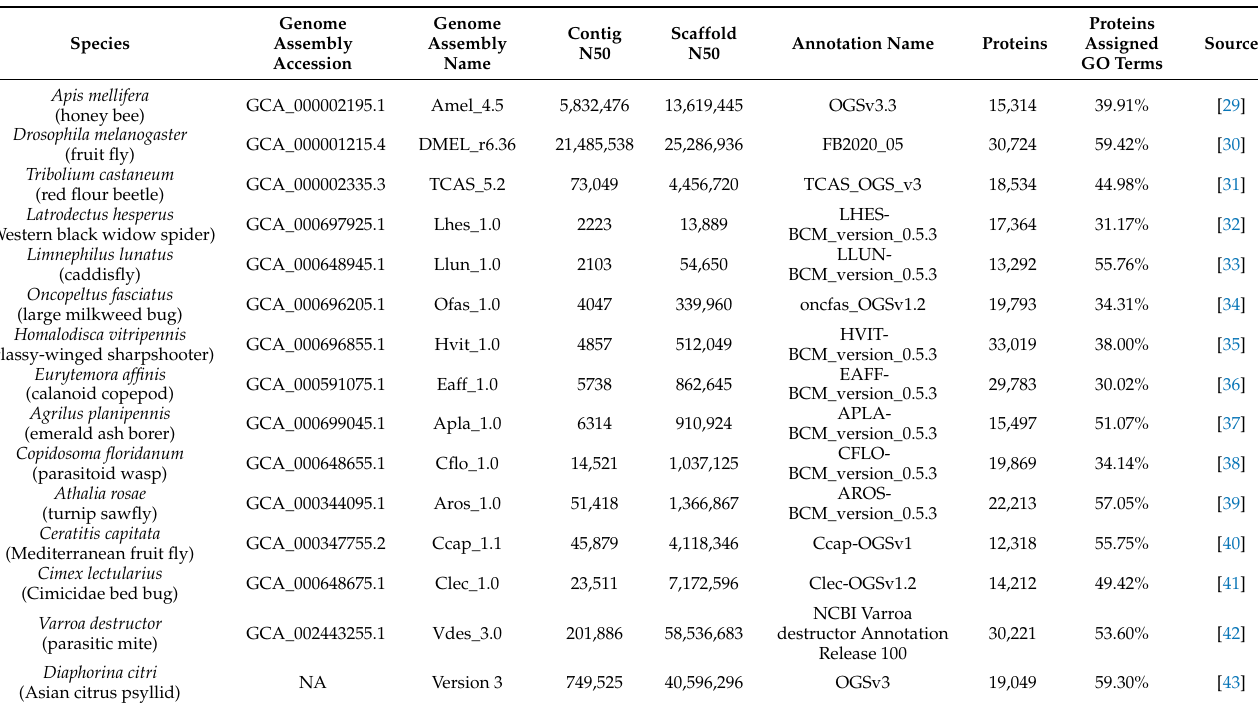
Table 3. Arthropod genomes selected for this study and their assembly and annotation statistics. The test species are sorted by the scaffold N50